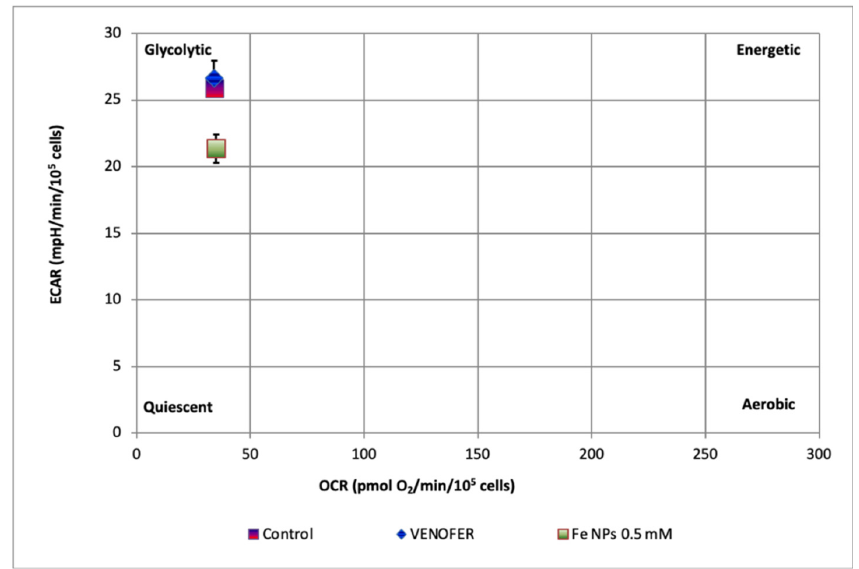
Figure 6. ECAR:OCR ratio plot showing the metabolic phenotype of HT-29 cells treated or not with iron nanoparticles FeNPs or Venofer ® . Data represent the mean ± SEM ( n = 3).